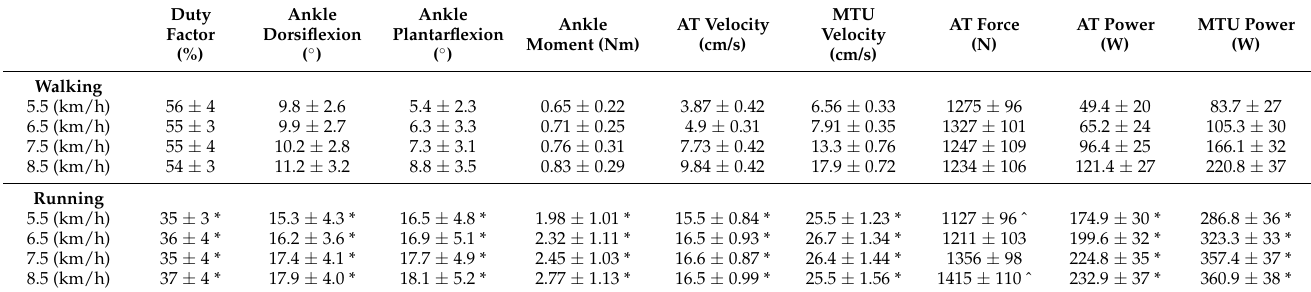
Footnote: ^ Significant difference ( p < 0.05) between walking and running at paired speed. * Signifi- cant difference ( p < 0.001) between walking and running at paired speed.